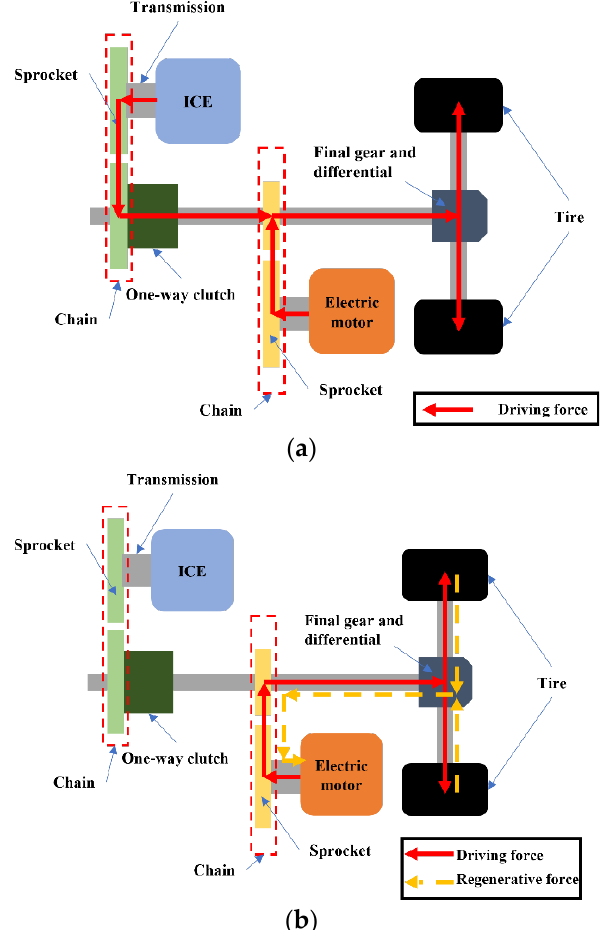
Figure 4. Proposal of a device for combining traction force generated by an ICE and electric motor. ( a ) Acceleration. ( b ) Deceleration.